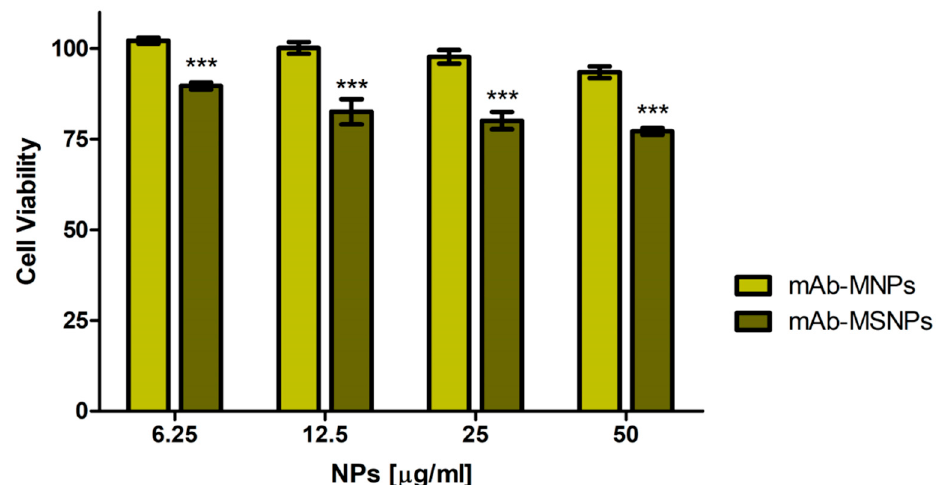
Figure 4. Cytocompatibility of the mAb-functionalized magnetic nanoparticles. Viability of GTL-16 cells was assessed in MTT assays after three days incubation. Data are expressed as % cell viability with respect to control untreated cells. For statistical analysis all data were compared vs. untreated samples (*** p < 0.001).